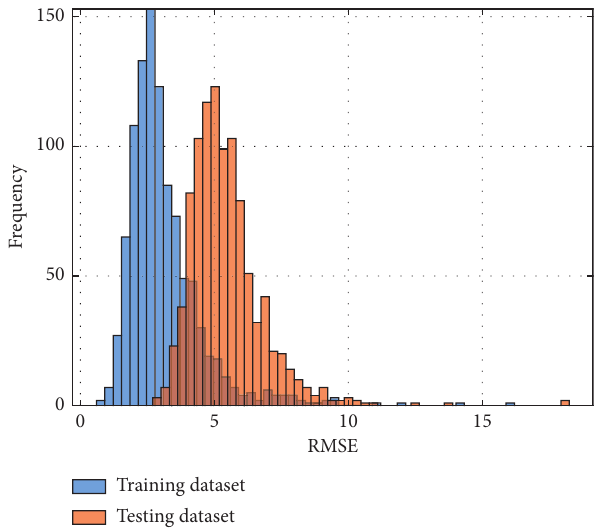
Figure 3: Histogram of RMSE values over 1000 simulations for the training and testing parts.